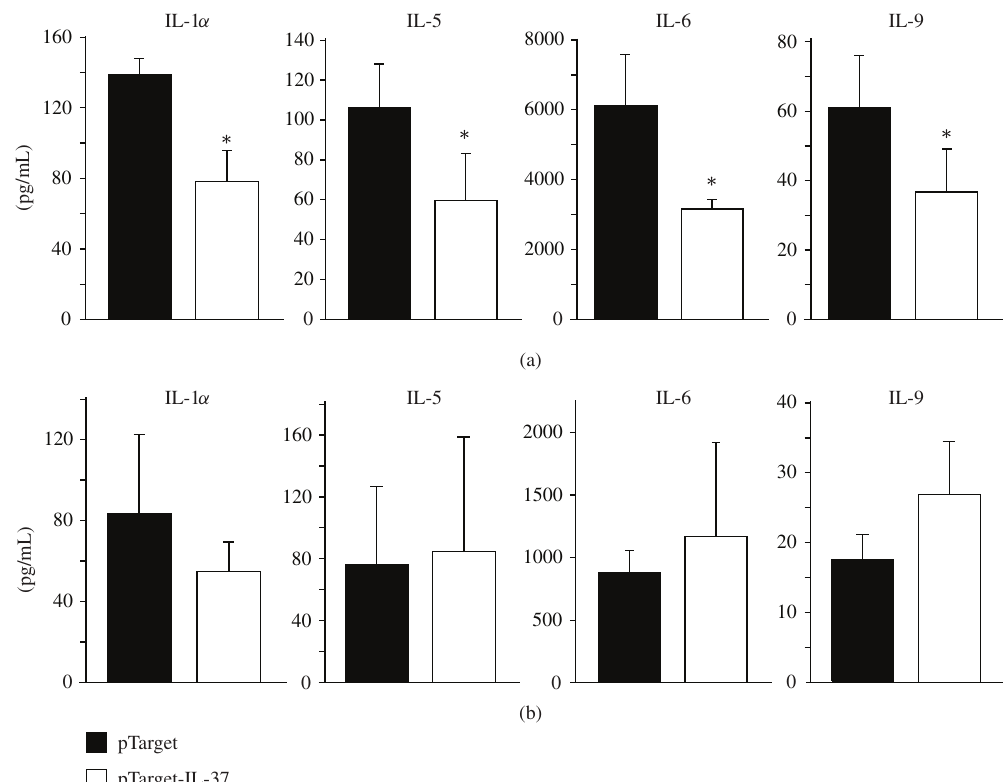
FIGURE 5: Expression of serum cytokines in IL-37-expressing mice after ConA-induced hepatitis. Serum cytokines were measured by a multiarray cytokine assay 2 hrs (a) and 24 hrs (b) after ConA treatment in IL-37 expressing mice (open bars, n = 4 ) and control mice (closed bars, n = 3